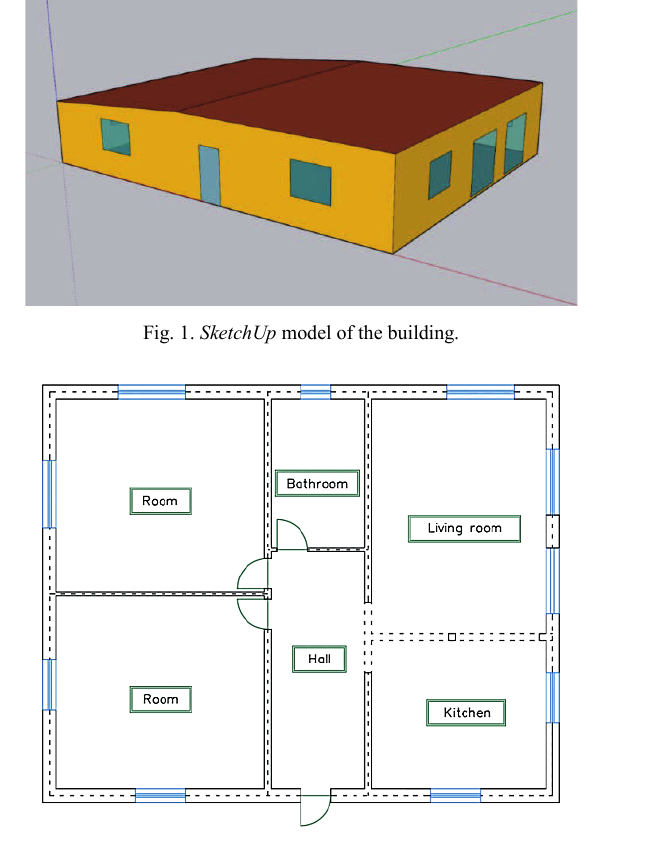
Fig. 2. Ground floor plan of the